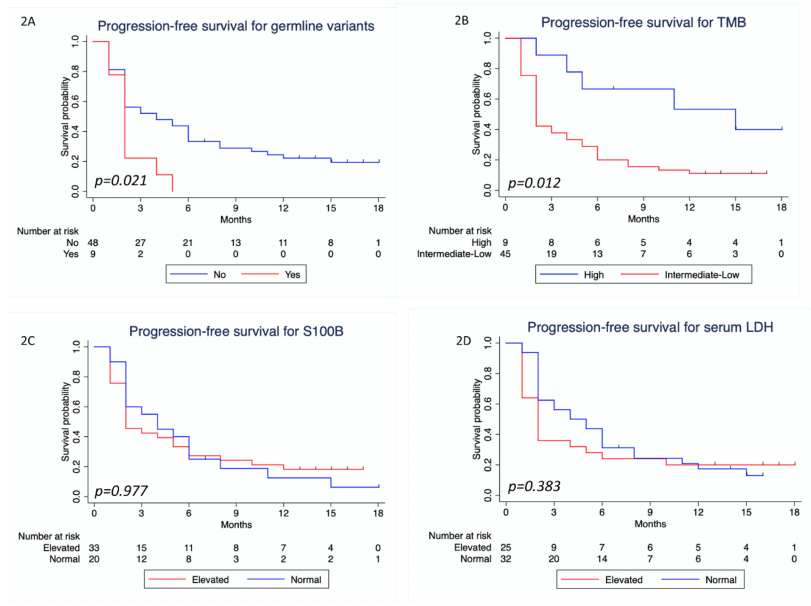
Figure 2. Progression-free survival analysis. ( A ) Kaplan–Meier curve for progression-free survival, considering the presence of pathogenic and likely pathogenic germline variants (Yes / No); ( B )Kaplan–Meiercurveforprogression-freesurvivalconsideringTMBintermediate-low( ≤ 23.1mut / Mb) or high ( > 23.1 mut / Mb); ( C ) Kaplan–Meier curve for progression-free survival considering serum S100B levels (normal / elevated); ( D ) Kaplan–Meier curve for progression-free survival considering serum lactate dehydrogenase (LDH) levels (normal / elevated). p -values refer to two-sided log rank tests.